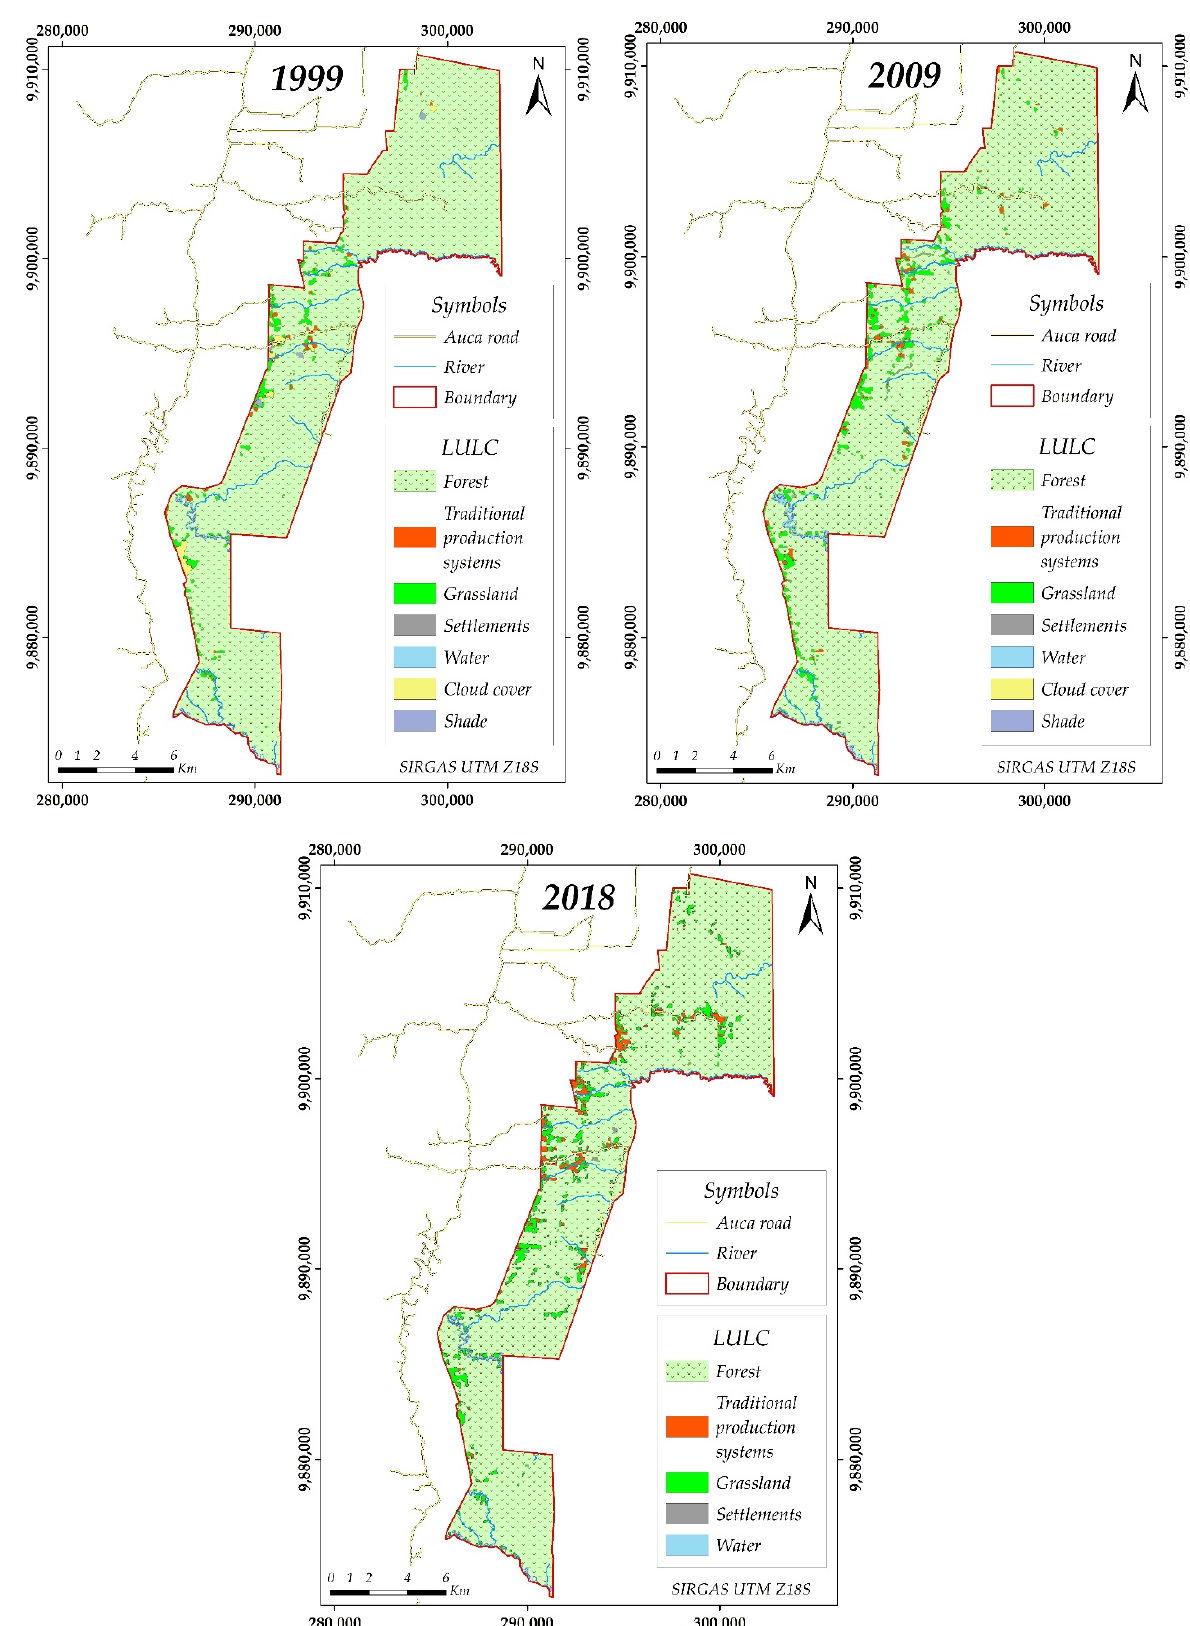
Figure 8. LULC maps for 1999, 2009, and 2018 of the DLZ’s southern zone (Inés Arango Parish) in the Yasuní Biosphere Reserve of the Ecuadorian Amazon Region.